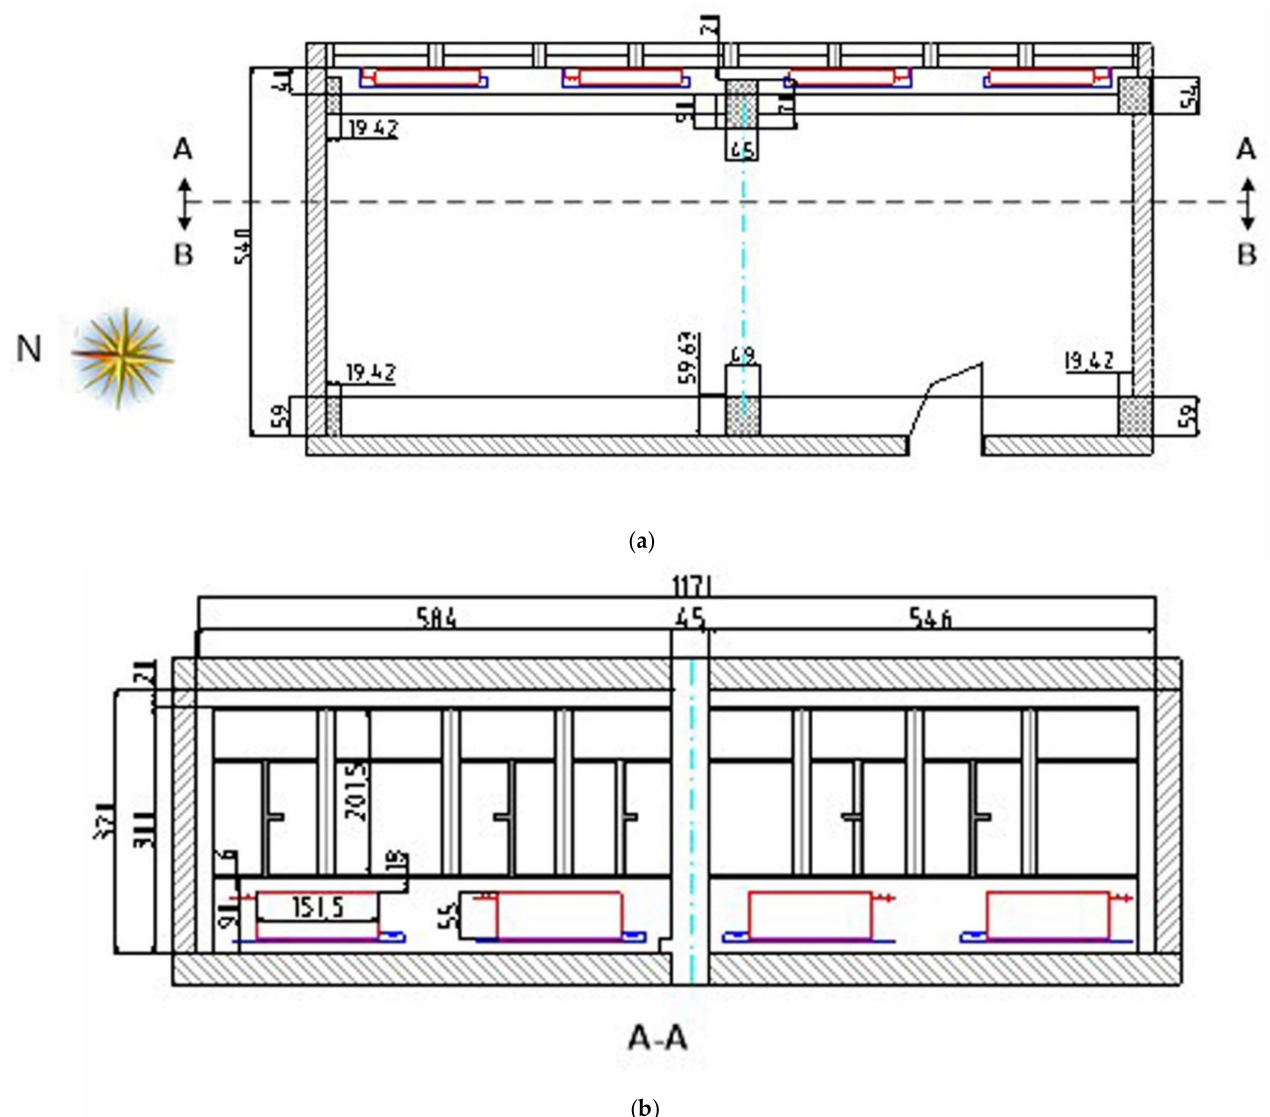
Figure 2. Drawing of the classroom: ( a ) Top view; ( b ) Cross-section